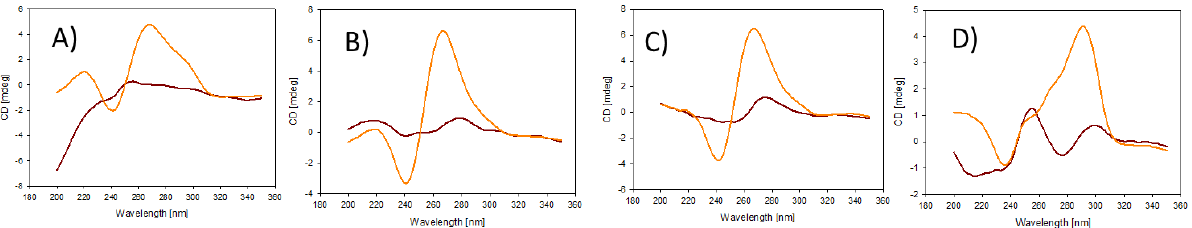
Figure 7: CD spectra of DNA oligonucleotides: LNA1 (A), LNA2 (B), LNA3 (C) and HT22 (D) with addition of hemin with (orange) and without (brown) potassium cations. Conditions: 10 mM Tris-HCl (pH=8.0), 100 mM KCl, 2 µM DNA, 2 µM